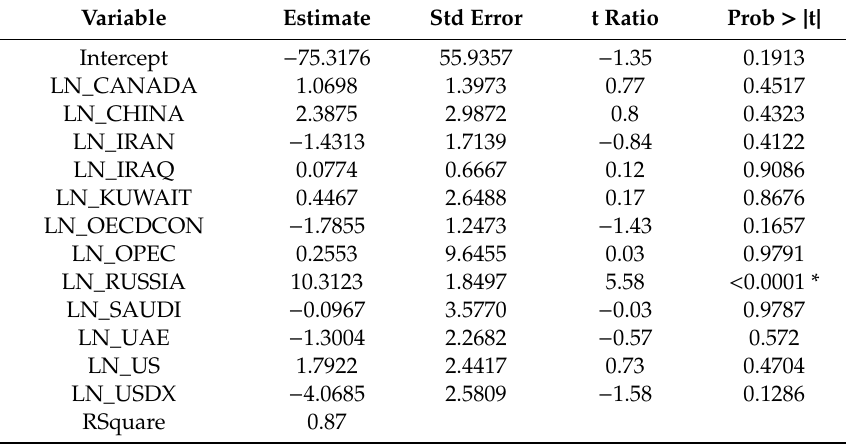
Table 6. Panel 1 period (1998–2000): LN_BRENT prediction-parameter